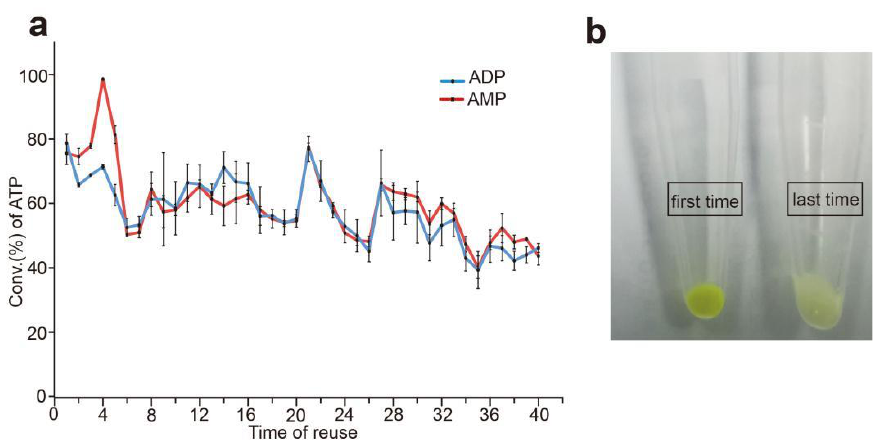
Figure 9. Reuse of intact cells for ATP production. ( a ): Reuse of the sfGFP-PAP-Pb intact cells. The reaction mixture contains 20 mM poly(P), 4 mM ADP or AMP, 30 mM Mg 2+ , and 50 mM Tris-HCl buffer (pH 8.5) and brought up to 1000 μL with double -distilled water, and moderate cells were added. After reaction at 37 °C for 20 min, the reaction mixture was centrifuged at 15,000 g for 5 min, and the pellet was used for the next reaction. ( b ): The green fluorescence of the sfGFP-PAP-Pb intact cells. Moderate cells were detected before and after reusing 40 times for the whole-cell catalysts.